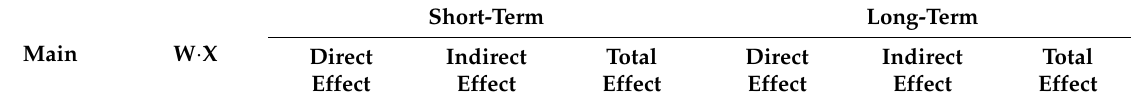
Table 5. Estimation results based on the dynamic